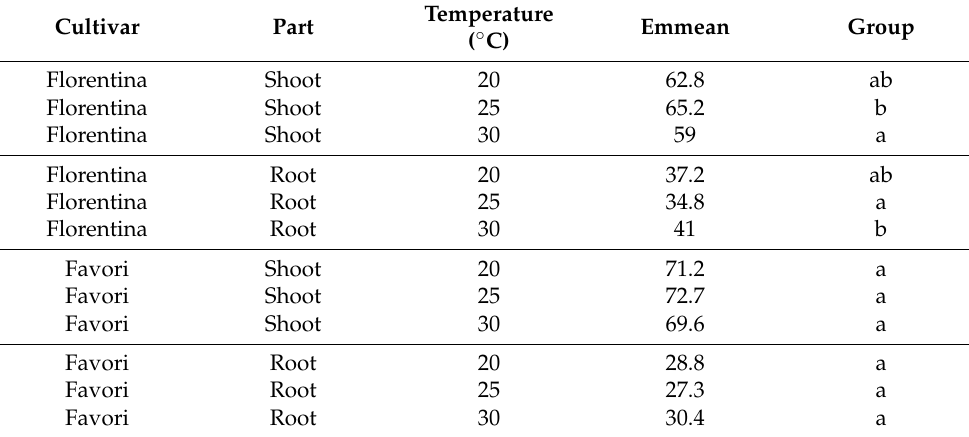
Table A5. Pairwise comparison using Tukey’s post-hoc test between the temperature treatments in SD for “Florentina’ and ‘Favori’. Similar letters denote non significance between the temperature treatments at p = 0.05. The least square means followed by the same lowercase letter did not differ statistically by the Tukey test at 5% of error probability ( p < 0.05).